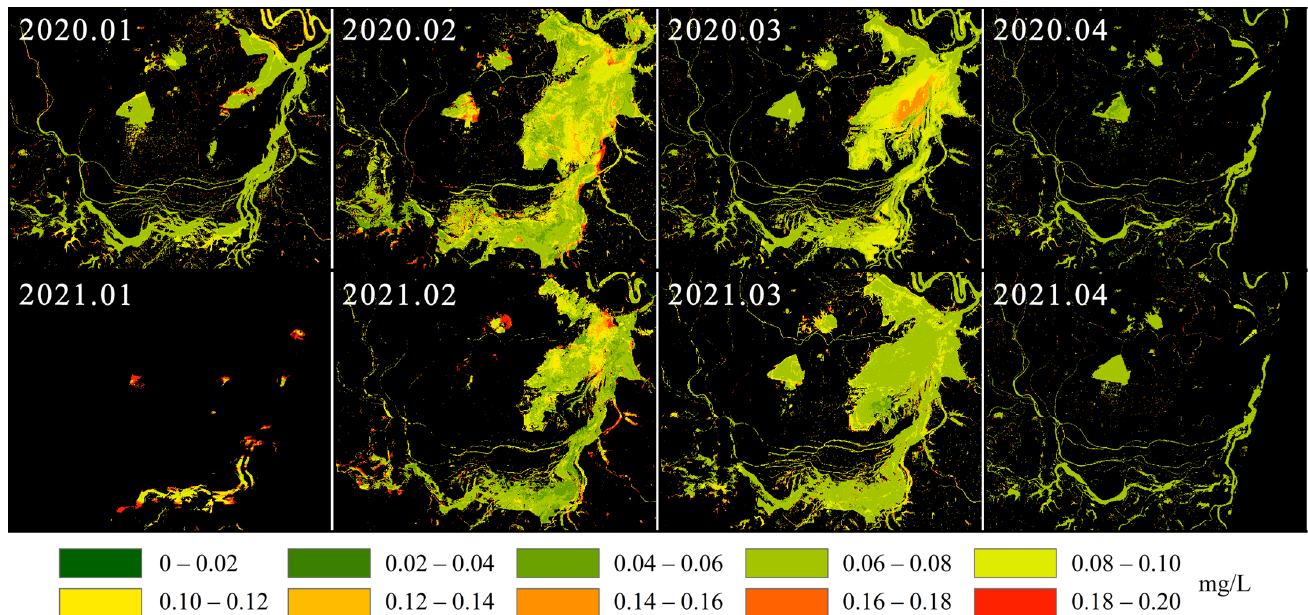
Figure A1. Quarterly distribution of TP in Dongting Lake.